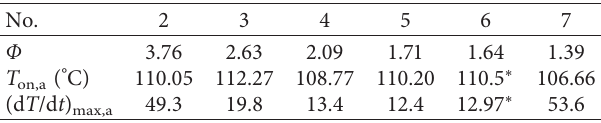
� 1.64 by the Fisher method. 1